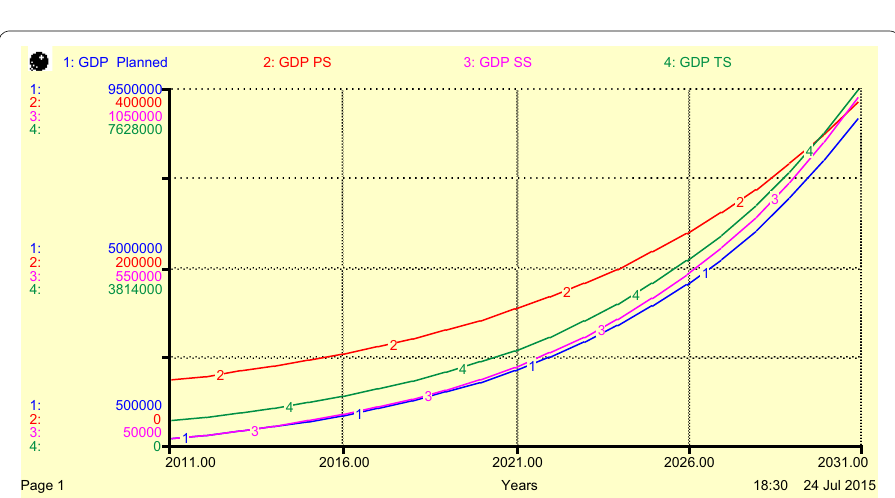
Fig. 22 Perceived projected GDP, GDP in Primary Sector, GDP in Secondary Sector, and GDP in Tertiary